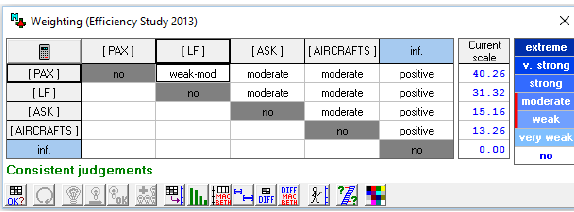
Figure 7: Ponderation (Weighting) Table.